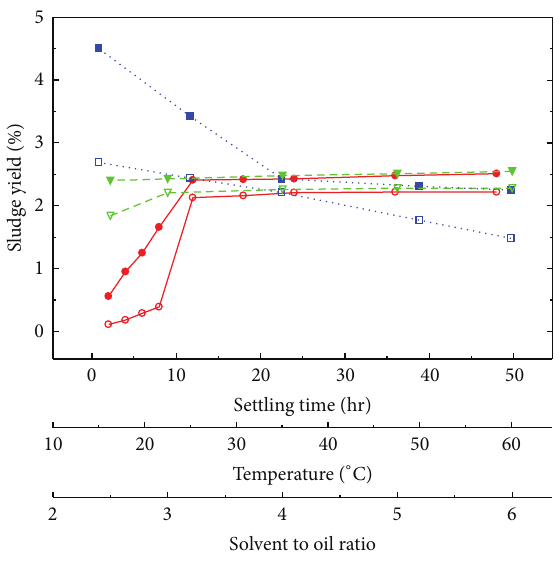
Figure 1: Experimental sludge yield during liquid-liquid solvent extraction of a representative spent lubricant as function of process variables 𝑡 , 𝑇 , and 𝑟 .